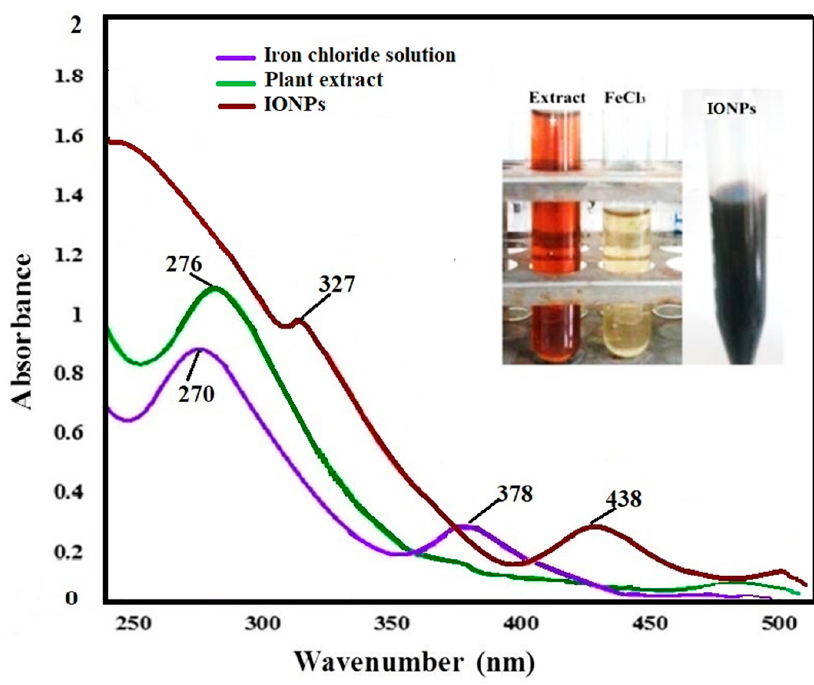
Figure 1. UV-Vis spectra of Terminalia chebula -employed iron–oxide nanoparticles